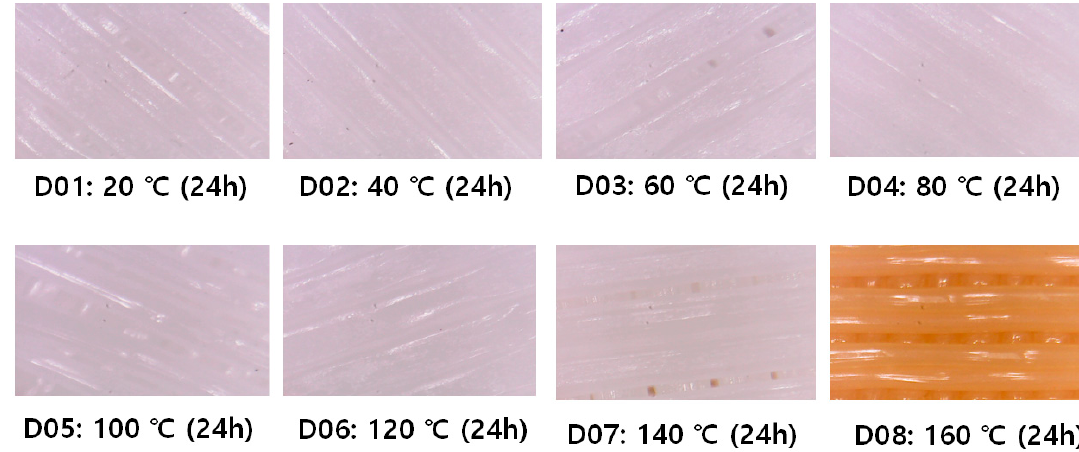
Figure 6. 3D printed polylactic acid (PLA) specimens according to the degree of thermal